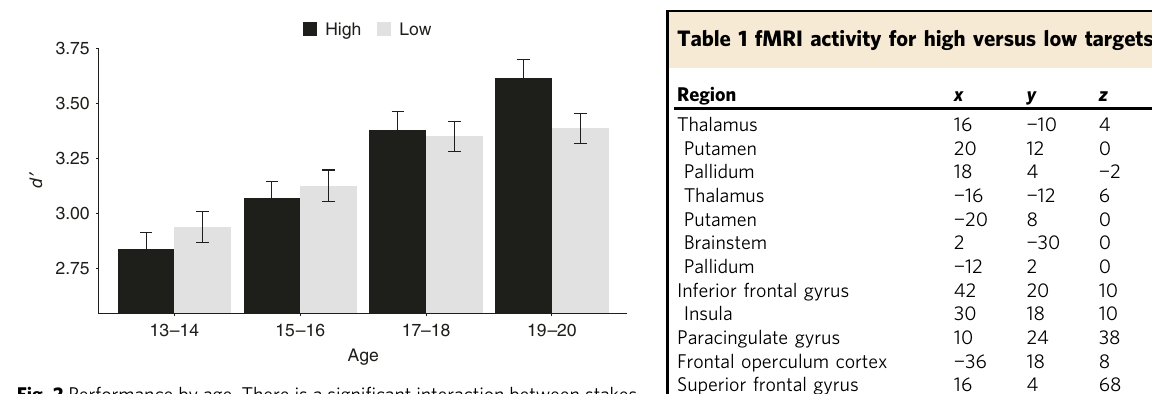
Fig. 2 Performance by age. There is a signi fi cant interaction between stakes and continuous age, with an emerging rise in performance under high compared to low stakes with increasing age ( F (1,86) = 4.24, p = 0.04). The x -axis depicts age in two-year bins ( n = 88 total, grouped for visualization purposes). D ′ ( y -axis) represents cognitive control performance. High (black bars) and low (gray bars) denote trial stakes. Bar heights represent the mean and error bars denote ± 1 standard error of the mean. For individual data, see Supplementary Fig. 2